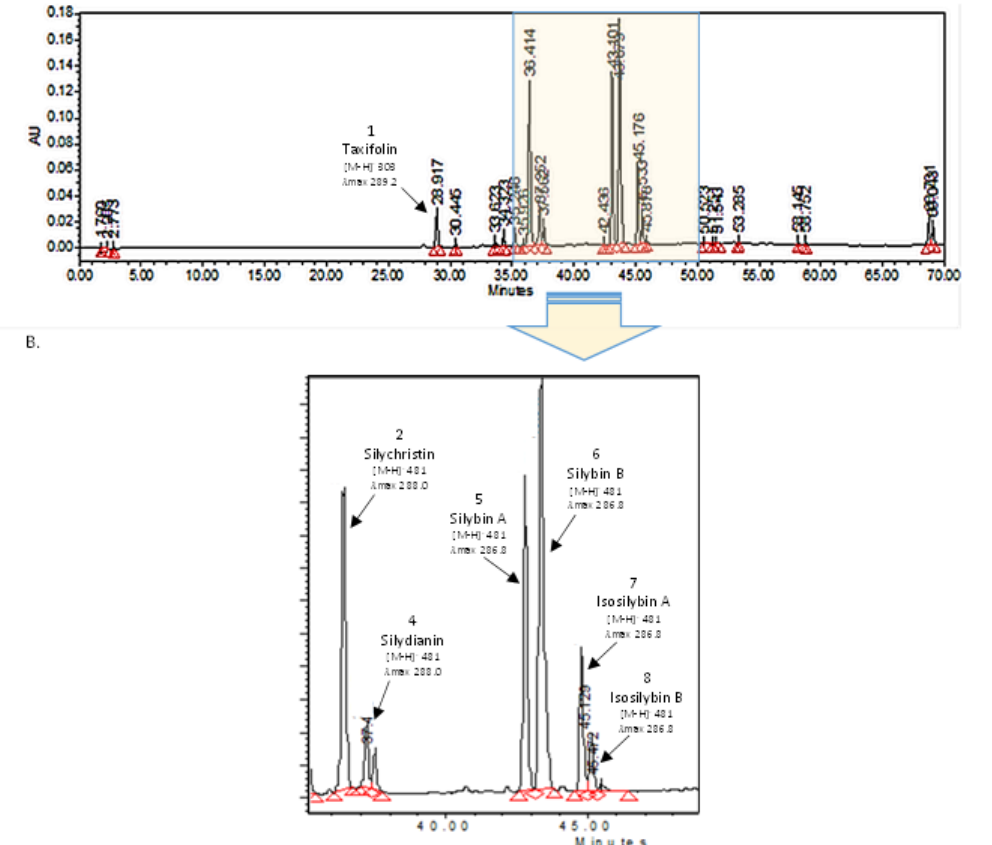
Figure 2. Representative chromatogram of a complete HPLC analysis ( A ). The main compounds considered in this study are the flavonoid taxifolin and all flavonolignans: silychristin, silydianin, silybin A, silybin B, isosilybin A, and isosilybin B. Presented on a magnification ( B ). Mass spectra